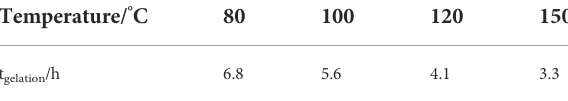
TABLE 5 Impact of temperature in experimental pulp on gelling